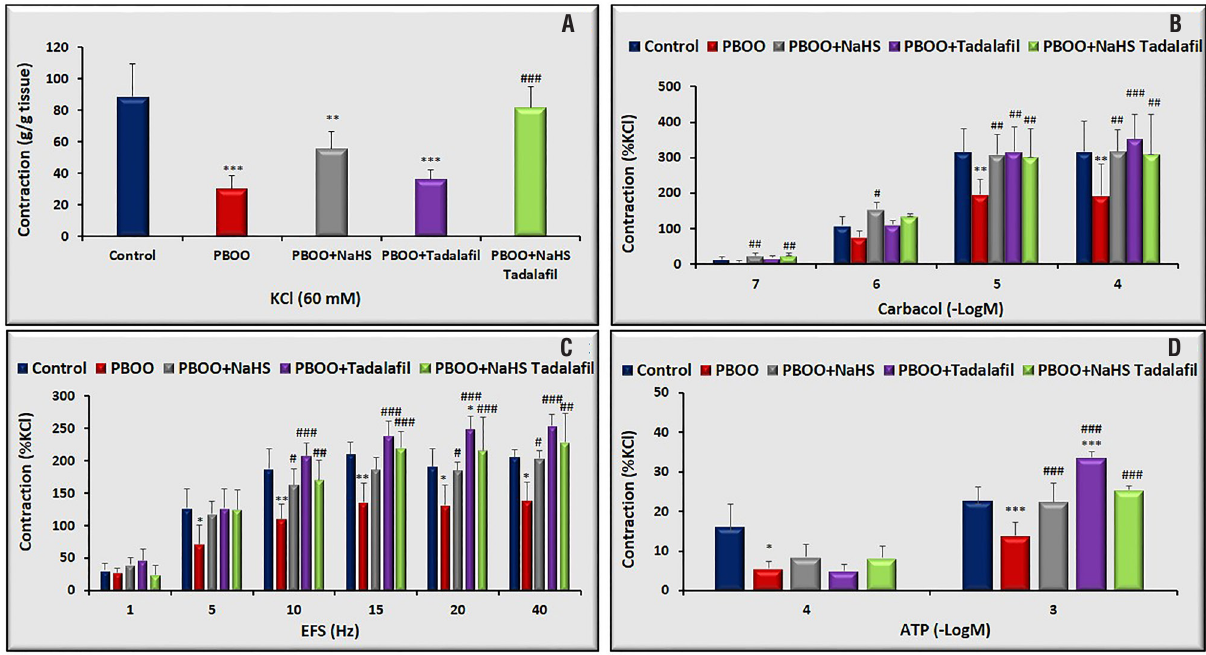
Figure 1 - Contractile dose-response curves for A) KCl, B) carbachol, C) electrical field stimulation and D), ATP in bladder strips from all